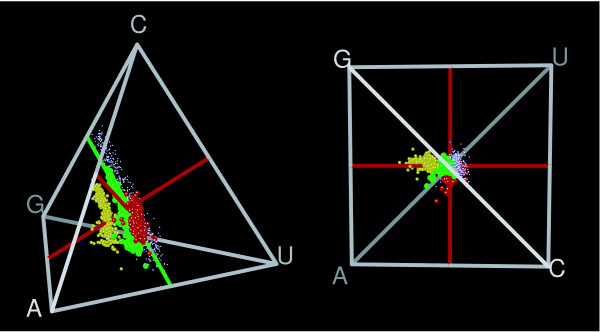
Relationship between base composition and code error. Bacterial codon usages are chosen to illustrate this relationship by plotting the base composition and code-error value for each codon position in the tetrahedral simplex (composition space). The error value for each species is plotted as a sphere with volume proportional to the error. Two perspectives are given. On the left is an oblique view to show variation along Chargaff's axis (G = C and A = T) and the relative contribution of each codon position to the error value. On the right is a view down Chargaff's axis to show the bias of each codon position. First position, yellow; second position, red; third position, blue; and total, green. As expected, the error value is always lowest at the third position (blue) as result of interconversion among synonymous codons and codons for similar amino acids.